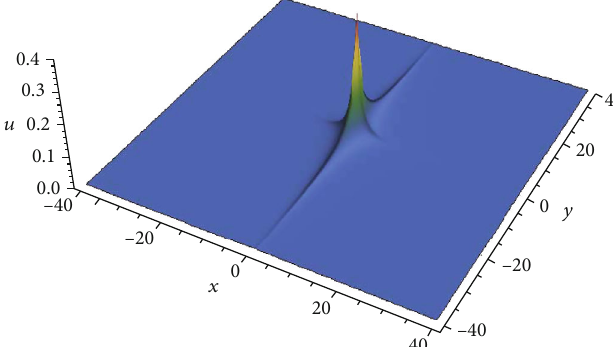
= 1 , p = 1/2 , σ = 1 , ξ ð 0 Þ = 0 , and t = 0 . 1 1 1